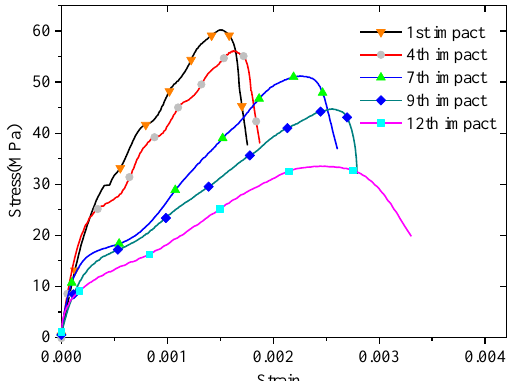
Figure 9. Dynamic stress–strain curves of sandstone specimens under repeated impact tests.